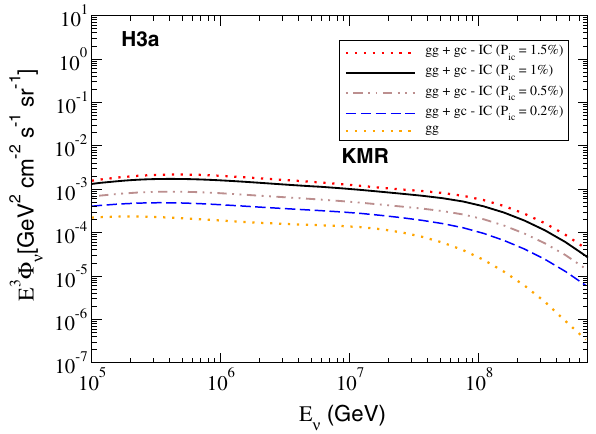
Fig. 7 Predictions of the hybrid model for the the prompt neutrino flux (rescaled by E 3 ν ), calculated using the KMR model for the uPDF. The IC contribution was obtained with p t 0 = 2 GeV and assuming different values for the probability to find an intrinsic charm. The H3a prametrization of the cosmic ray flux is used in this